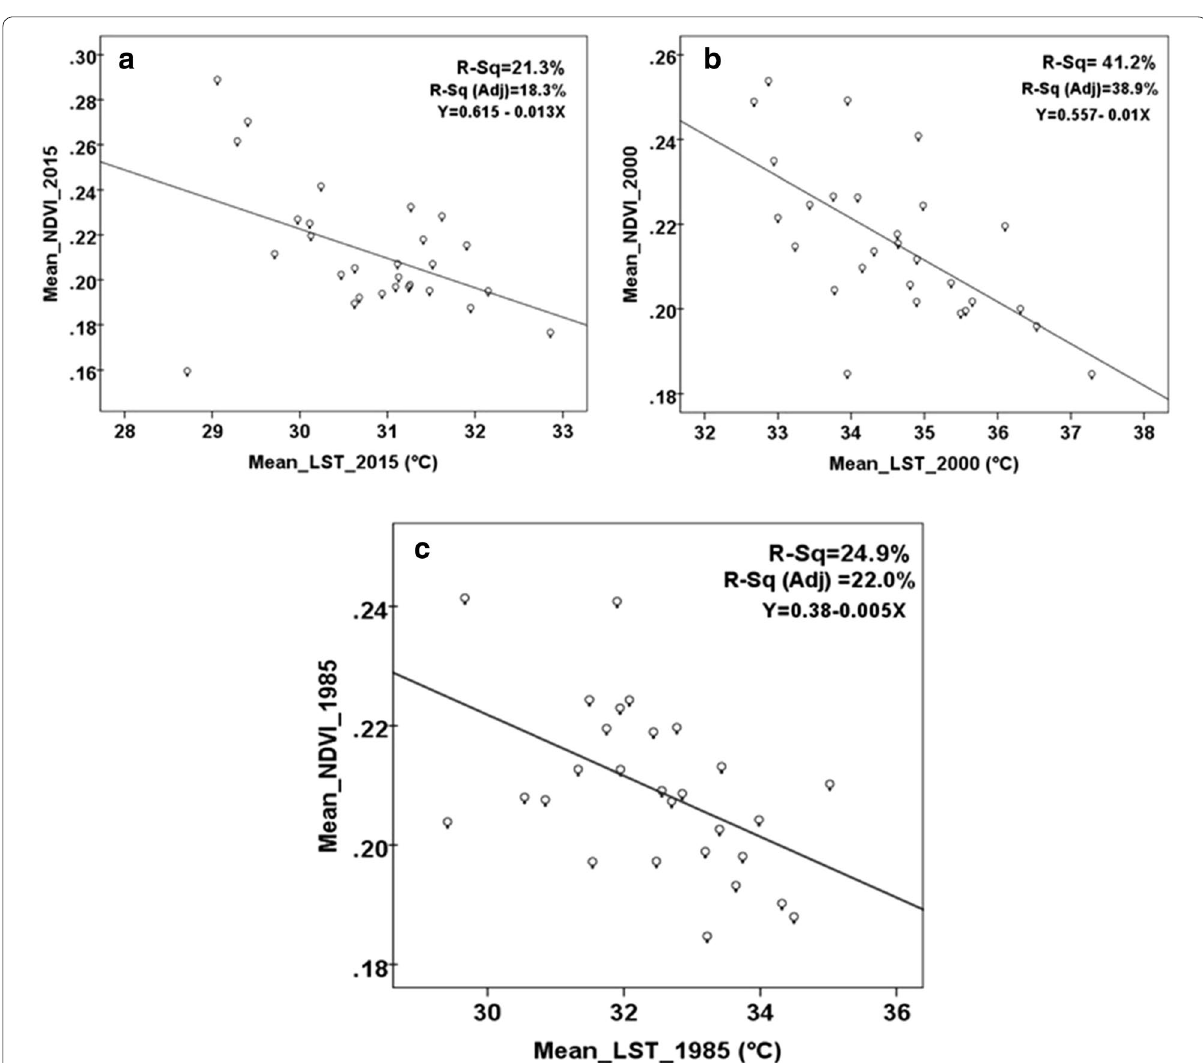
Fig. 9 The mean LST and SAVI relationship over years 1985, 2000 and 2015 at village polygons. a regression plot between mean NDVI of 2015 and mean LST of 2015; b regression plot between NDVI of 2000 and mean LST of 2000; and c regression plot between NDVI of 1985 and LST of 1985 (all at village